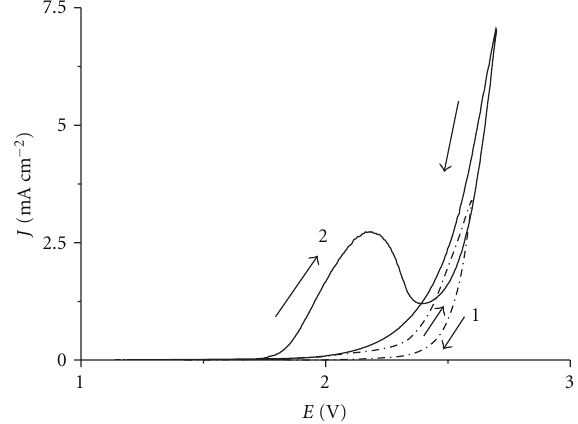
Figure 1: Cyclic voltammograms in 0.5 M K 2 SO 4 solution: (1) benzene-free solution, (2) benzene-saturated solution. (In what fol- lows, all experimental results are given for the 0.5M K 2 SO 4 solution, unless otherwise stated.) Potential scan rate 20 mV/s. Arrows show the direction of potential sweep.